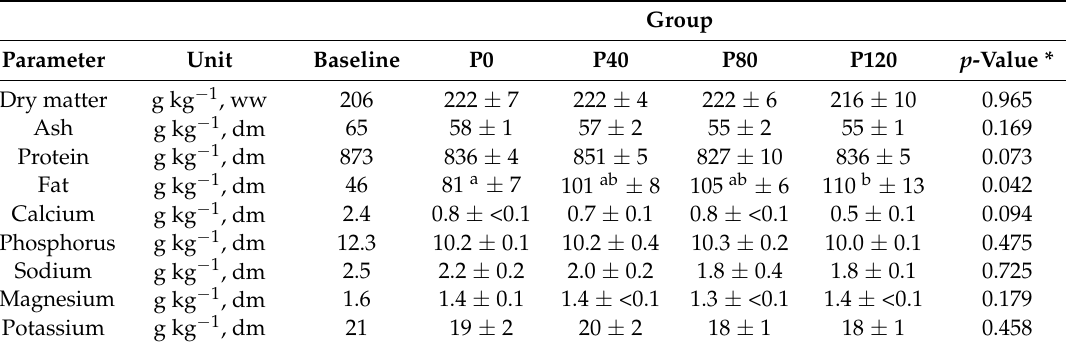
Table 4. Initial and final fillet composition of C. gariepinus (n = 3).